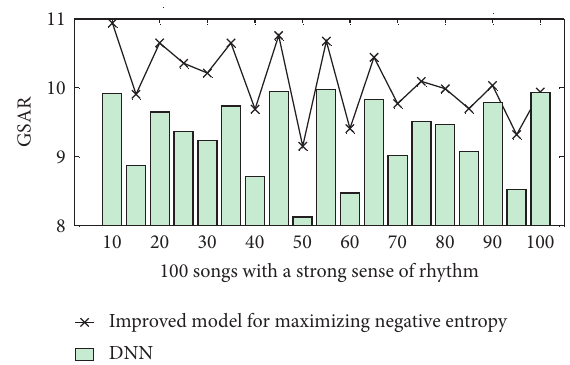
Figure 10: 100 pieces of music separation results with strong rhythm in MIR-1K.